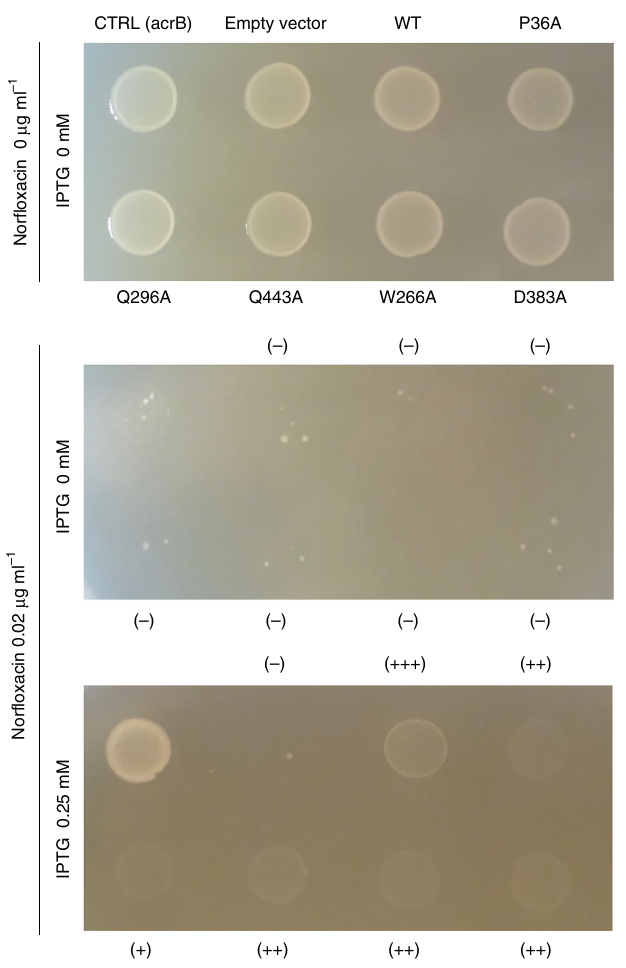
Fig. 1 In vivo complementation analysis of AtDTX14. Nor fl oxacin-resistance growth assay of AtDTX14 and its mutants was performed, using the 6- knock-out E. coli strain. AtDTX14 expression was induced by 0 mM (top panel, non induction control, 12 h) and 0.25 mM IPTG, with 0 μ g ml − 1 (middle panel, 18 h) or 0.02 μ g ml − 1 (bottom panel, 12 h) of nor fl oxacin. The mutants that decreased the complementary activity are labeled with (+) or (++), and those that showed the wild-type AtDTX14 level of complementary activity are labeled with (+++). The transformant of the single knock-out strain ( BW25113 acrAB:: Δ macAB:: Δ yojHI:: Δ ) harboring the isogenic wild-type acrB inducible expression vector was included as